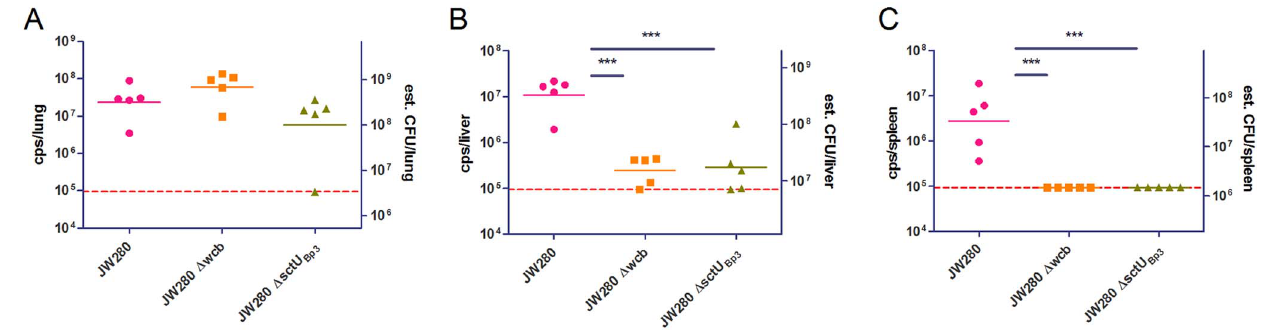
Fig. 7. Bacterial enumeration of B.pseudomallei mutants in moribund respiratory disease. Groups of 5 female albino C57BL/6J mice were infected with wild type JW280 (10 4.2 CFU), D wcb capsule mutant (10 6.0 CFU), or D sctU Bp3 T3SS3 mutant (10 6.5 CFU), and euthanized at moribund disease endpoints. Bacteria were enumerated from tissues ex vivo by optical imaging (left Y-axis: cps/tissue) with presentation of the estimated tissue CFU burdens based on calculated tissue-specific cps:CFU correlation (right Y-axis: CFU/tissue est.) for lung (A), liver (B) and spleen (C). The 95% LOD was calculated as a technical background luminescence and indicated as a dotted horizontal line. Data points below the 95% LOD were set to the 95% LOD value. Significant differences (1-way ANOVA with Tukey posttest) between log transformed data sets are indicated with an adjoining line (*, p , 0.05; **, p , 0.01; ***, p , 0.001).